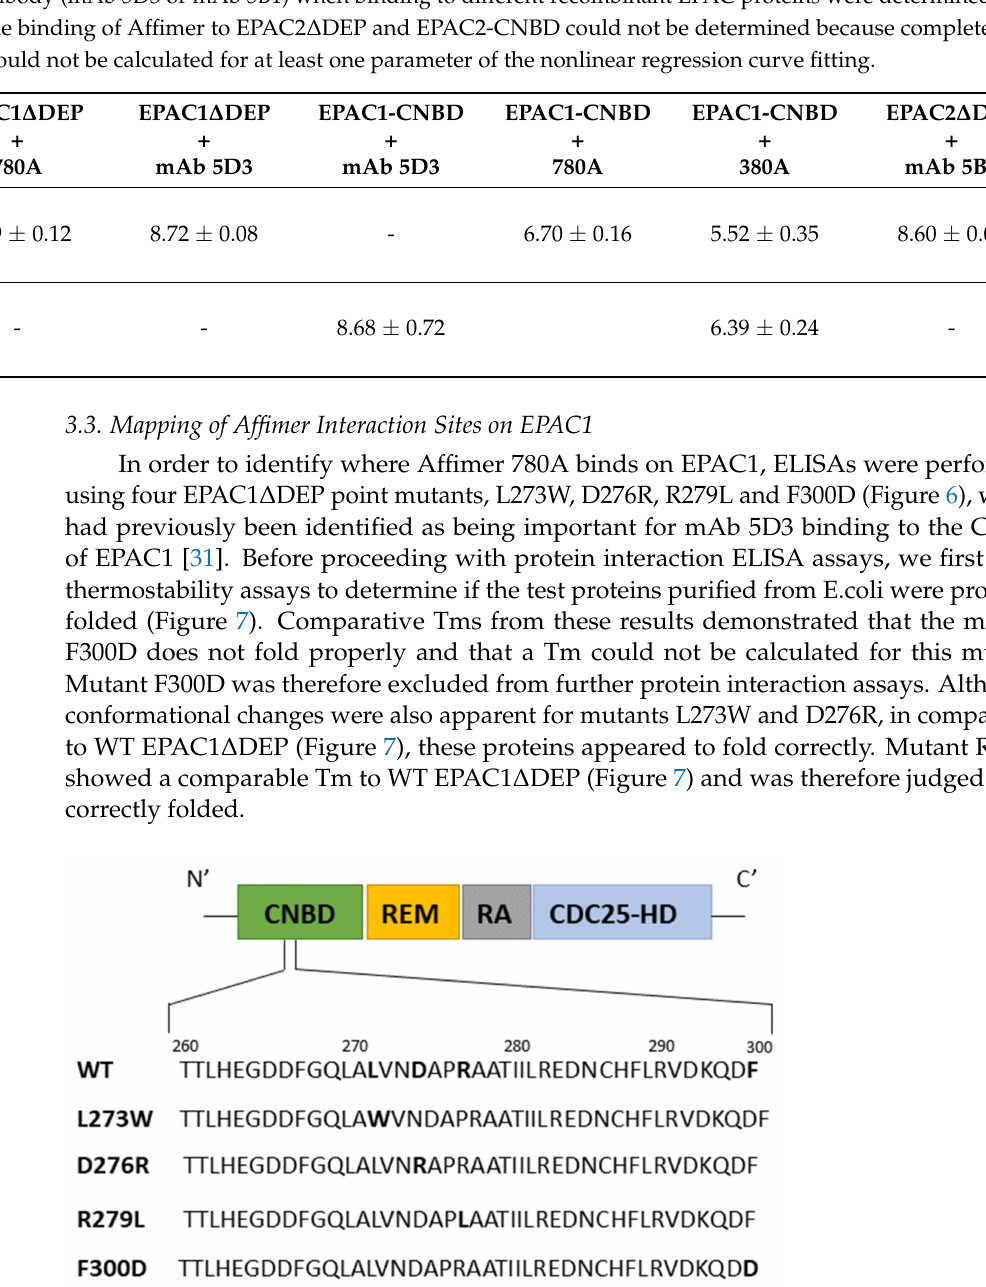
Figure 6. EPAC1 ∆ DEP structure and sequence alignment. Domain organization of